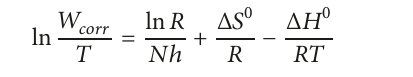
of inhibitors during 4h, varying